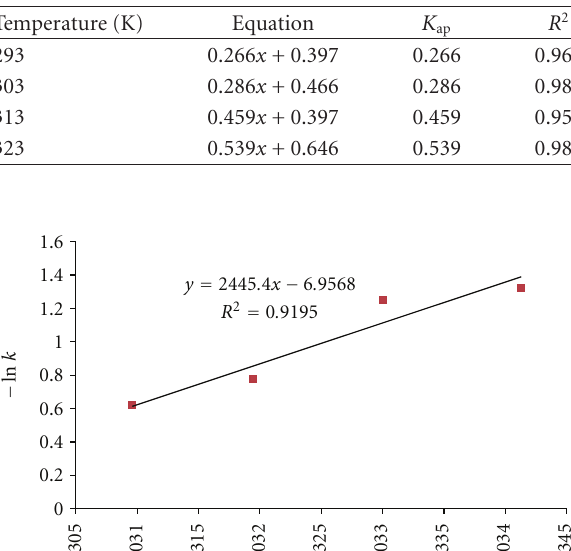
Table 4: E ff ect of temperature on photocatalytic degradation of aniline under UV illumination in HCBR (experimental conditions: